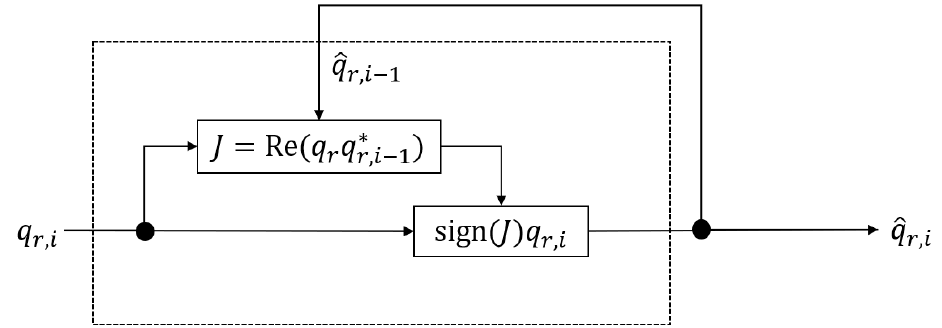
Figure 2. Block diagram of stateful